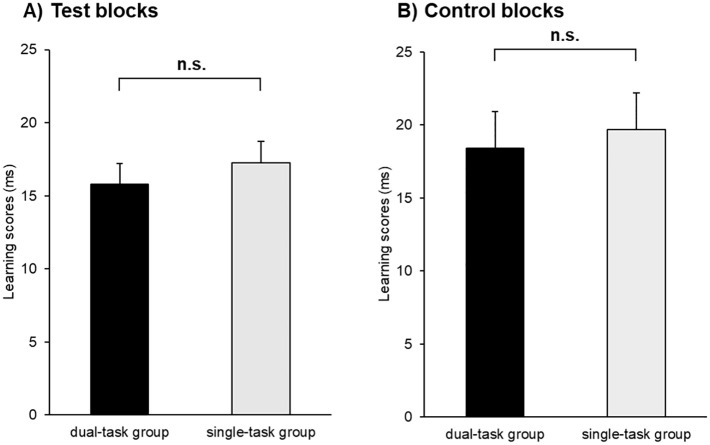
The learning scores of (A) the test blocks and (B) control blocks of the retrieval phase.The horizontal axes represent the two groups. The vertical axes indicate the learning scores (RTs for the low-probability triplets minus RTs for the high-probability triplets, the blocks collapsed together). The error bars signal the standard error of the mean. The learning scores of the two groups did not differ in the test blocks or the control blocks. We found similar results with standardized scores. n.s.: p > .05.